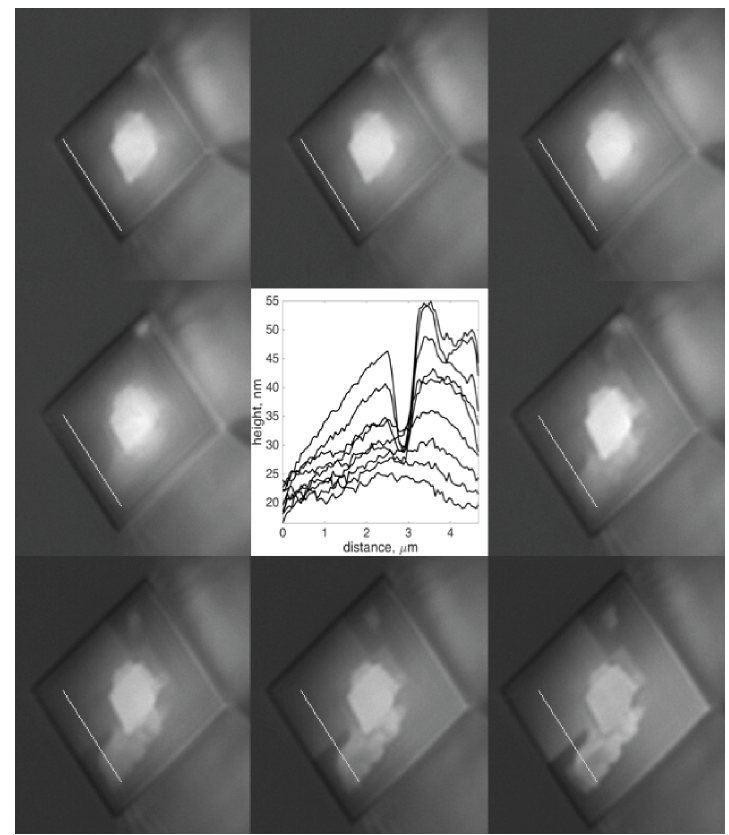
Figure 7. Evolution from smooth to rough growth rim for Crystal H at Ω = 0.6. The images are 10 × 12 µ m, and the time between images is 6 min. The figure shows height profiles along the white line in the images demonstrating how the initially smooth, flat surface develops a “protrusion” pushing the crystal up and tilting